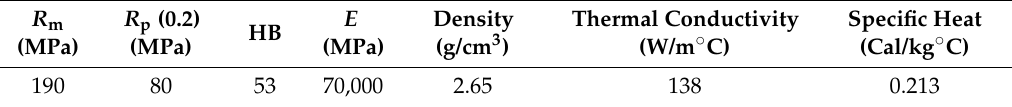
Table 2. Mechanical properties of AA5754-H111 perpendicular to the rolling direction.